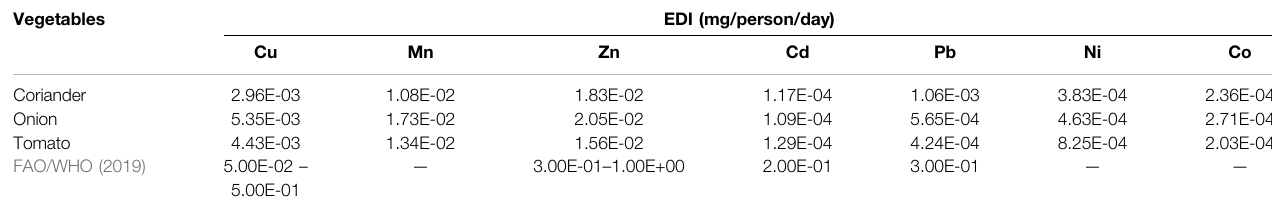
TABLE 5 | EDI due to consumption of different vegetables by adults.